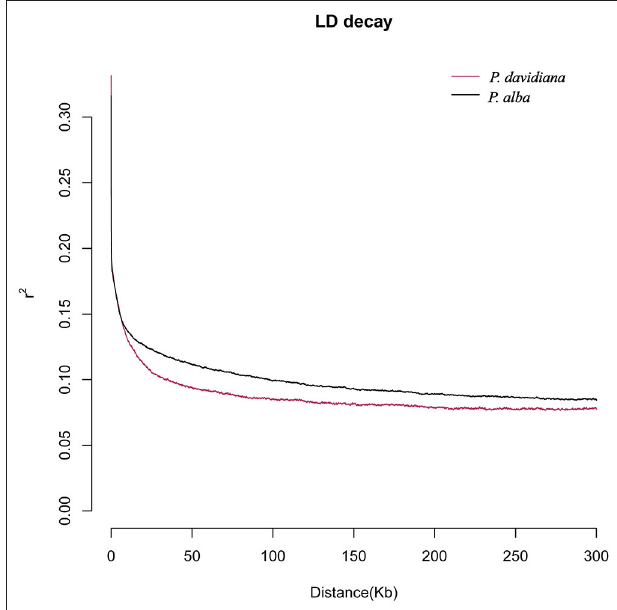
FIGURE 3 | Linkage disequilibrium decay patterns for P. davidiana and P. alba .